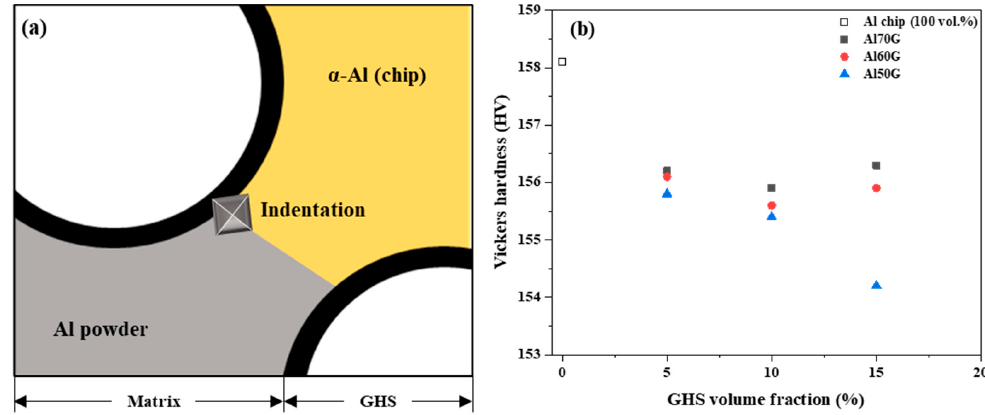
Figure 5. ( a ) Region of hardness measurement; ( b ) hardness variation in Al chip and Al powder matrix with volume fraction of GHS.